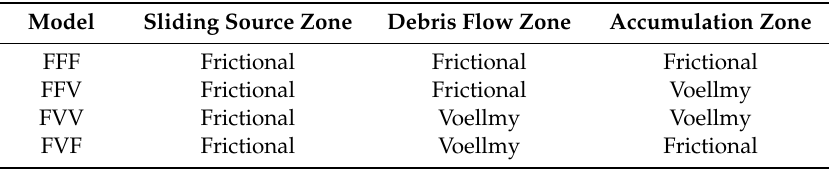
Table 1. Hydrodynamic model of the Panjinbulake